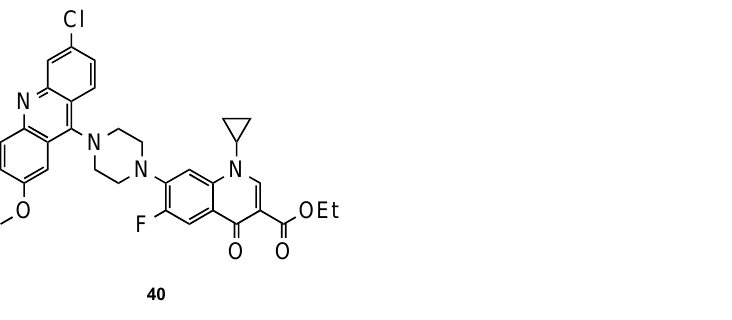
Figure 26. CFX – acridine hybrid 40 developed by Dana and co-workers [56]. Blackie et al. [59] established the role of ferrocenyl moiety in the antiplasmodial ac- tivity of ferroquine, another import scaffold in antimalarial derivatives [60]. The authors concluded that ferrocenyl fragment serves simply as a hydrophobic spacer group. Next, they synthesized compound 41 (Figure 27) and tested them against CQS 3D7 and CQR K1 strains of Pf . It is noteworthy that hybrid 41 showed potent antimalarial activity (ED 50 = 1 and 8 nM against CQS 3D7 and CQR K1 Pf strains, respectively), comparatively to CQ Figure 27. Ferrocene – acridine hybrid 41 developed by Blackie and co-workers [59]. (ED 50 = 8.52 and 290 nM against CQS 3D7 and CQR K1 Pf strains, respectively) [59]. This review depicts a brief background of the development of antimalarials based on the heteroaromatic core of QN focused on the last two decades. Despite the potent antimalarial activity of QN , its toxicity was among the reasons for its rapid substitution by CQ . Thus, all the modifications described in this review were mainly driven to increase the antimalarial activity of QN derivatives but also to improve their pharmacokinetic and pharmacodynamic properties, as well as overcome problems of cytotoxicity. The classical modifications in the side-chain of acridine reported in this paper emphasized